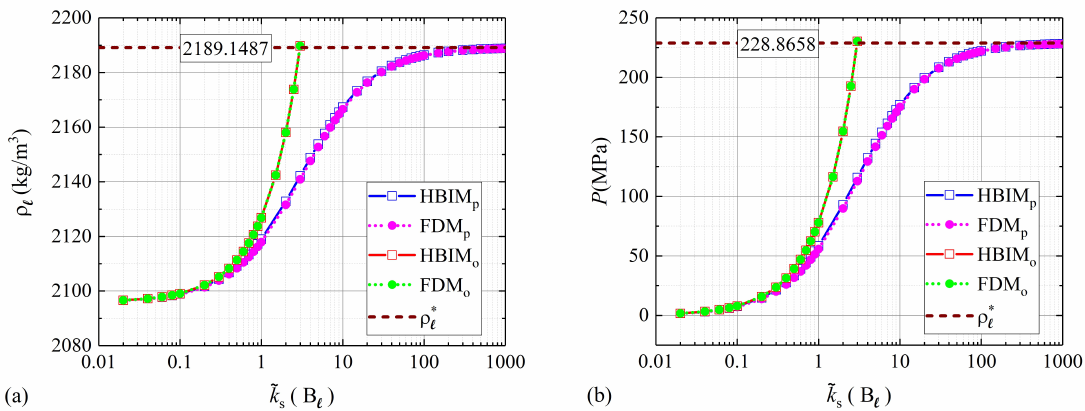
Figure 2. ( a ) Liquid density and ( b ) inner pressure at f s = 0.999. Numerical and semi-analytical solutions to the proposed model are shown in pink and blue symbols. The solutions to the model described in [18] are shown in green and red symbols. The dashed line corresponds to the asymptotic values for the density of the liquid ρ ∗ (cid:96) and inner pressure P ∗